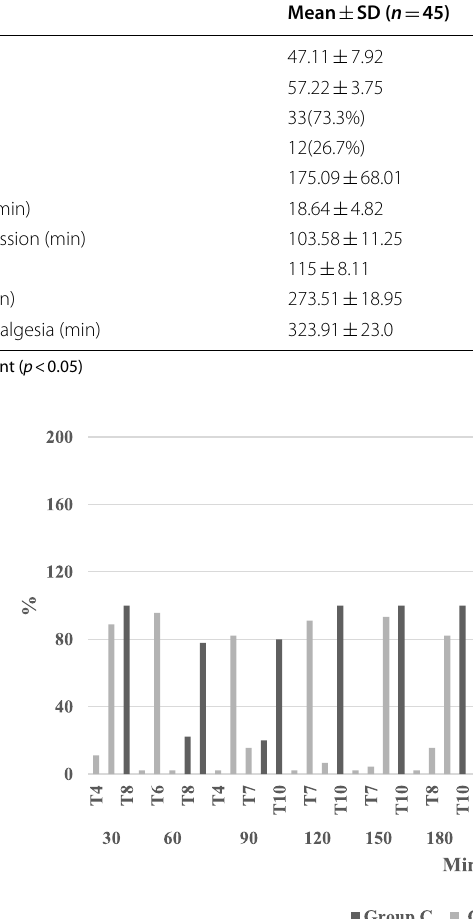
Fig. 1 Sensory level achieved in both the groups during peri- and postoperative